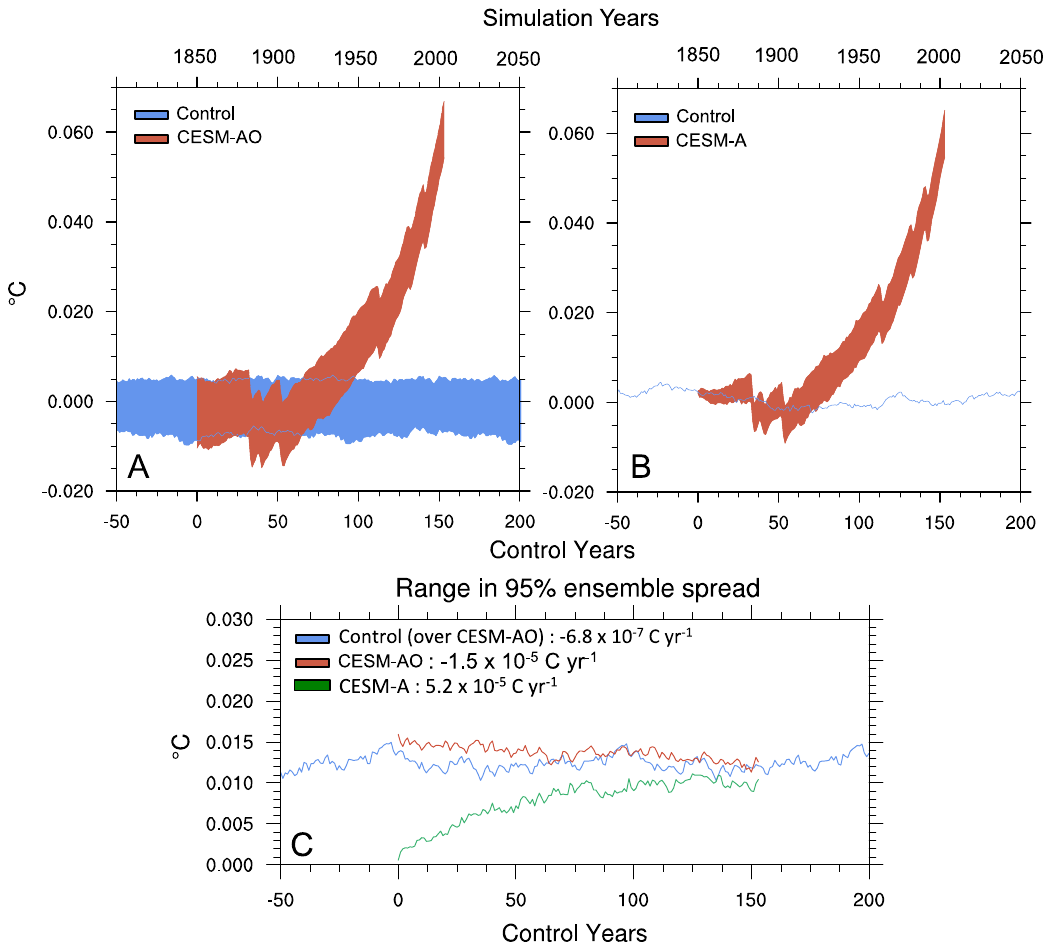
Figure 3. Globally averaged ocean temperature for CESM-AO ( A ) and CESM-A ( B ). See text for description of differences between ensembles. Blue lines ( A , B ) display timeseries of the oceanic temperature pre-industrial control simulation. Red lines ( A , B ) display historically forced simulations. The 95% range in ensemble spread is shown in ( A ) and ( B ). Timeseries of the 95% range are shown in ( C ). Values are the linear trend in ensemble spread over the period shown from 0–150 years.